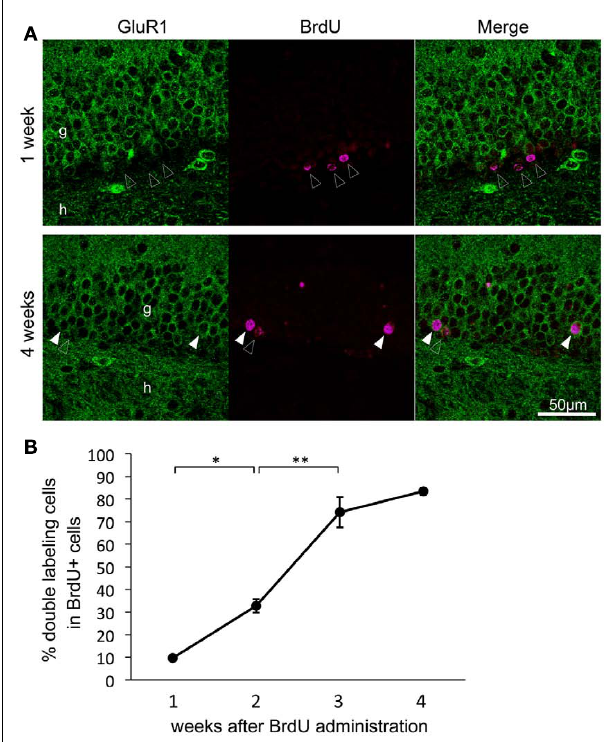
FIGURE 3 |Time course of the double-labeling of GluR1 with bromodeoxyuridine (BrdU) in the dentate gyrus granule cells. (A) Representative images of BrdU and GluR1 double-labeling at 1week (upper panel) and 4weeks (lower panel) after BrdU injection. Closed and open arrowheads indicate BrdU-positive cells with or without co-expression of GluR1, respectively. g, Granule cell layer; h, hilus. (B) Changes in co-labeling rates of BrdU with GluR1 in the dentate gyrus over a period of 4weeks after BrdU injection.Values are given as the means ± SEM of the analysis based on the results of three mice. Asterisks indicate statistically significant differences: ** p < 0.01 (one-way ANOVA andTukey’s post hoc test).